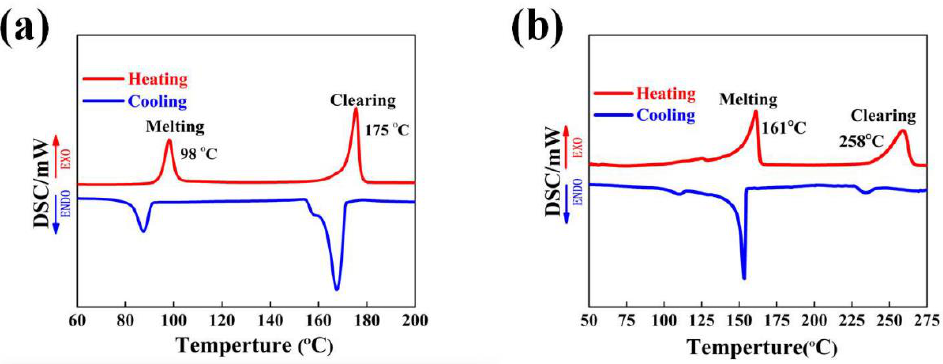
Figure 5. Differential scanning calorimetry (DSC) curves of BP6 ( a ) and GPLP ( b ).